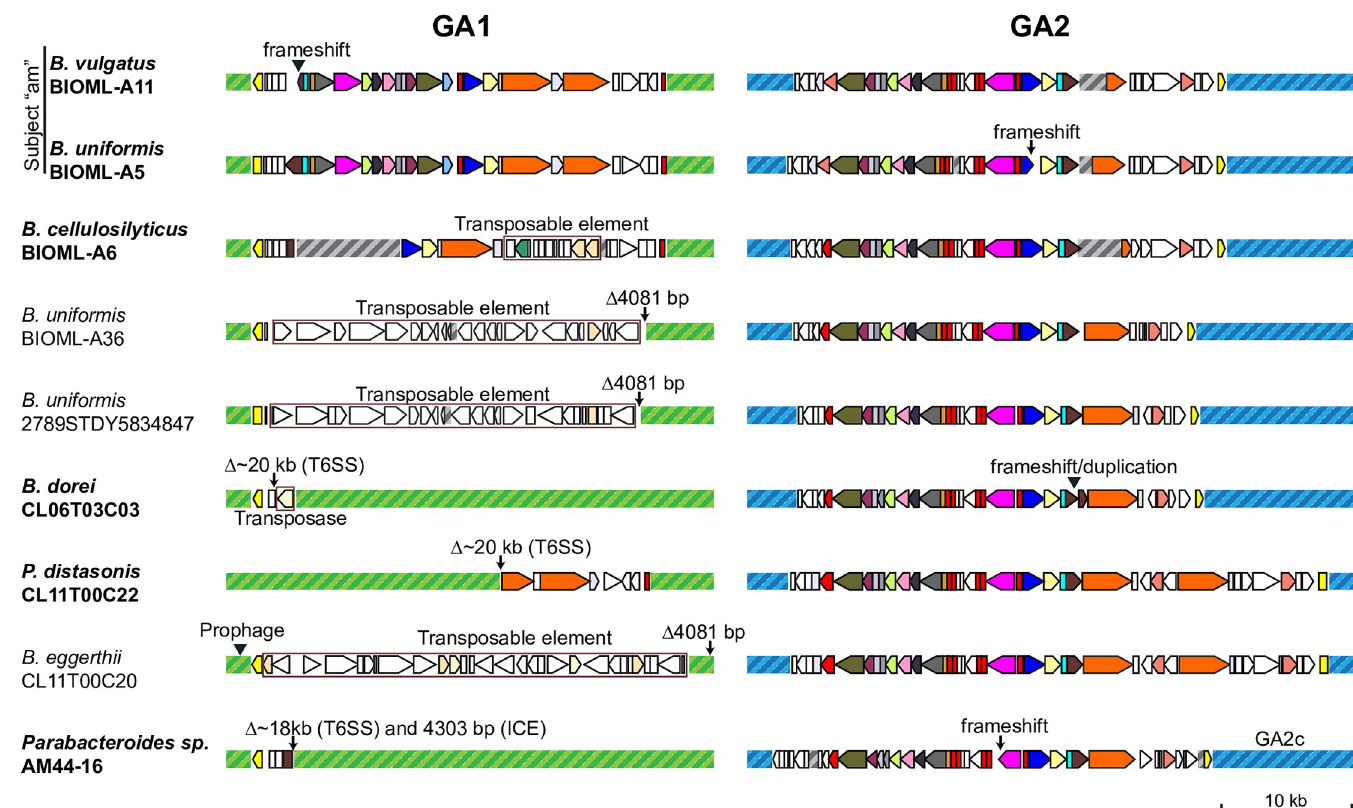
Fig 6. Schematic of genomes that have a GA1 and a GA2, where one of the regions is disrupted. Corresponding genomic coordinates for each region shown in S6 Table are included. Regions of the GA1 ICE outside of the T6SS locus are shown as hatched green boxes and those outside the GA2 T6SS locus are indicated by hatched blue boxes. All GA2 regions shown are of the GA2b subtype except where indicated. Grey hatched boxes indicate gaps in contigs or contigs that were joined manually. Color legend for the T6SS genes as specified in Fig 1. Strains with bolded names have disrupted T6SS regions, whereas non-bolded correspond to the same ICE carrying a different cargo. Insertions are indicated by filled triangles, deletions by arrows. Boxed regions indicate the bounds of a transposable element insertion or recombination event that replaced the cargo.